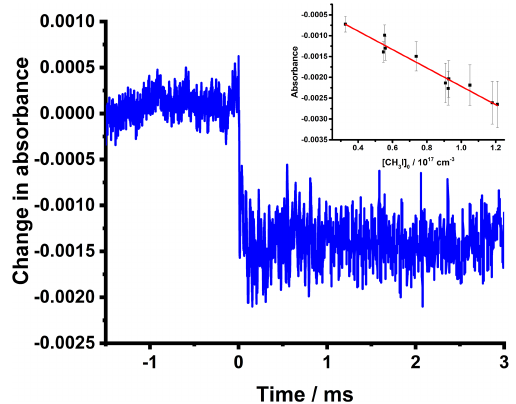
Figure 3. Changes in absorbance at ∼ 1287cm − 1 observed on 266nm photolysis of CH 3 I. For the data shown in the main fig- ure, [CH 3 I] 0 = 5 . 5 × 10 16 cm − 3 , p = 50Torr, and laser fluence is 30mJcm − 2 . The data shown are the means of 200 photolysis shots. The inset shows the average post-photolysis (0.5ms < t < 3 ms) change in absorbance as a function of the initial CH 3 I concentration (black points) with the line of best fit (red). The pre-photolysis re- gion for these experiments was defined as − 1 . 5ms <t < − 0 .